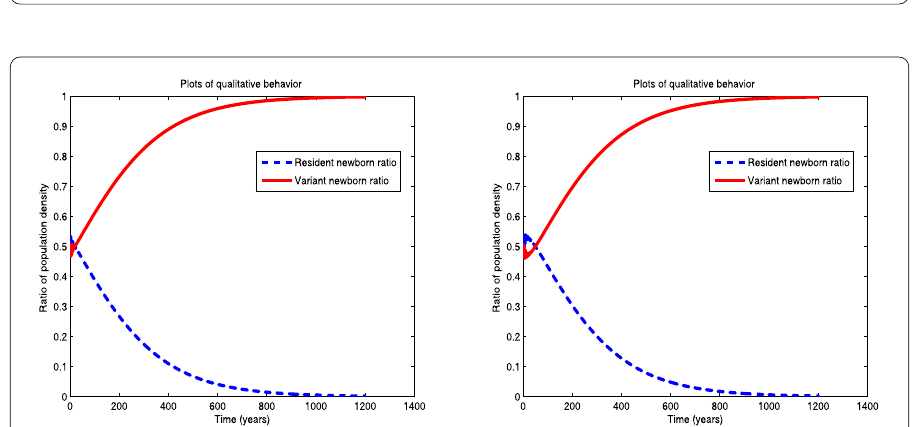
Figure 8 Region IIIb. Plot of newborn population ratios vs time. Parameters: h 2 = 0.5, h 3 = 0.8 on the left h 1 = 0 and on the right h 1 =